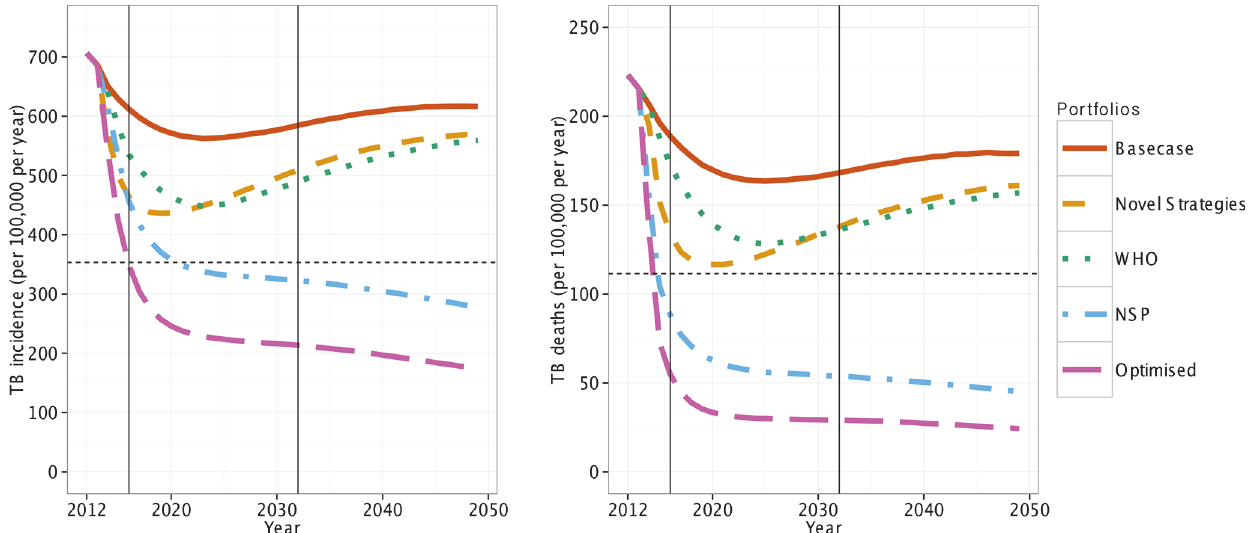
Fig 1. Basecase and impact of the four portfolios on TB incidence and mortality (/100,000/year). The “ NSP ” and “ Optimised ” portfolios have the biggest impact. The dashed horizontal lines are the NSP 2016 targets. The solid vertical lines show the timings of the NSP deadlines for 2016 and 2032.